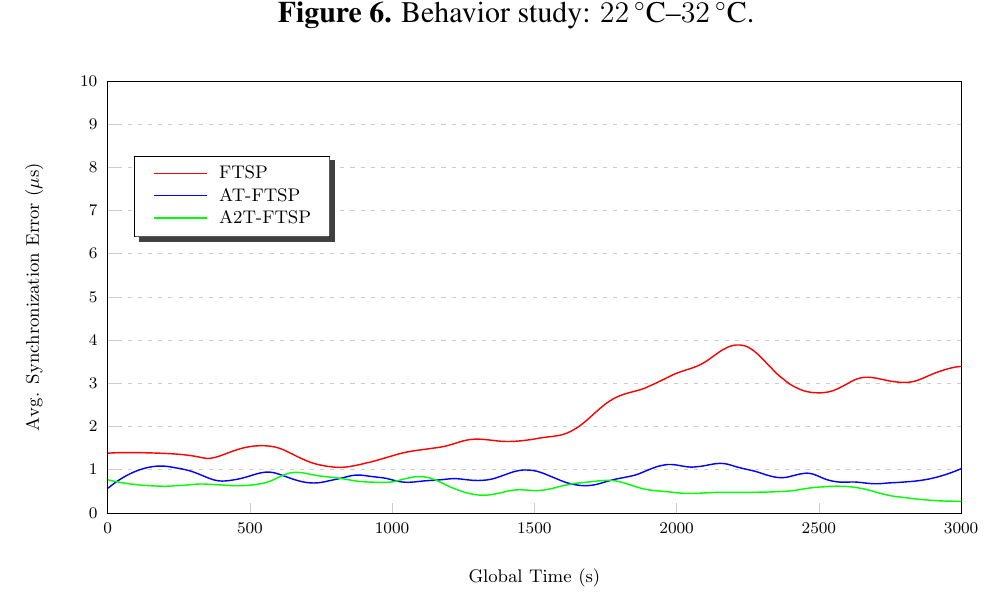
Figure 6. Behavior study: 22 ◦ C– 32 ◦